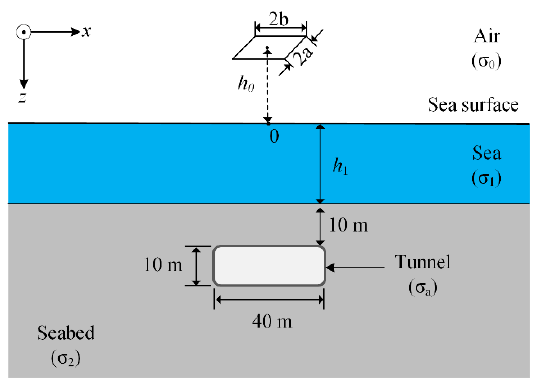
Figure 4. 2.5D model for a subsea tunnel buried in layered medium.